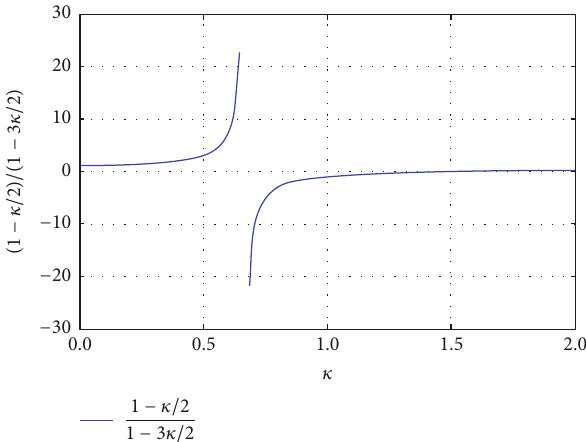
Figure 1: (Color online) term of amplitude dependence on 𝜅